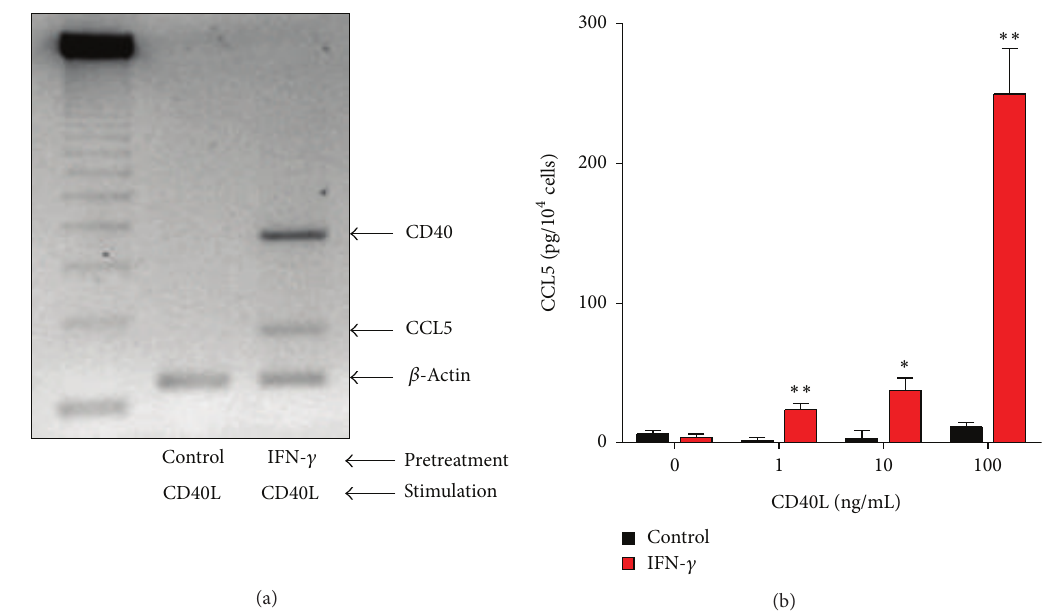
Figure 3: Effect of preexposure to IFN- 𝛾 on CD40L-induced CCL5 expression and release by HPFB. Cells were pretreated for 48 hours either with control medium or IFN- 𝛾 (100U/mL). After that cells were stimulated with CD40L for the next 24 hours. (a) Expression of mRNA for CD40 and CCL5 was assessed by conventional RT-PCR. Results of a representative experiment of two performed. (b) CCL5 release was measured in HPFB cultures established from 5 separate donors. Asterisks represent a significant difference compared to cells not exposed to IFN- 𝛾 .